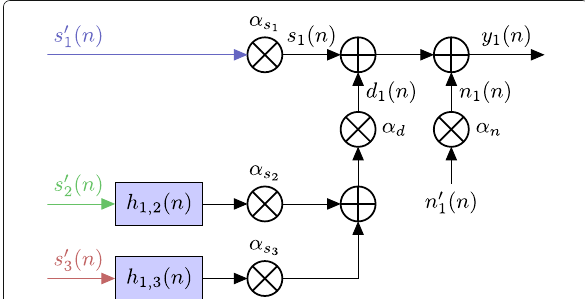
Fig. 3 Simulation diagram of the close-talk microphone signal y 1 ( n ) , employing input speech data, measured room impulse responses (RIRs), and assuming h m , m ( n ) = δ( n ) . For computation of microphone signals y 2 ( n ) and y 3 ( n ) , the inputs are to be changed accordingly